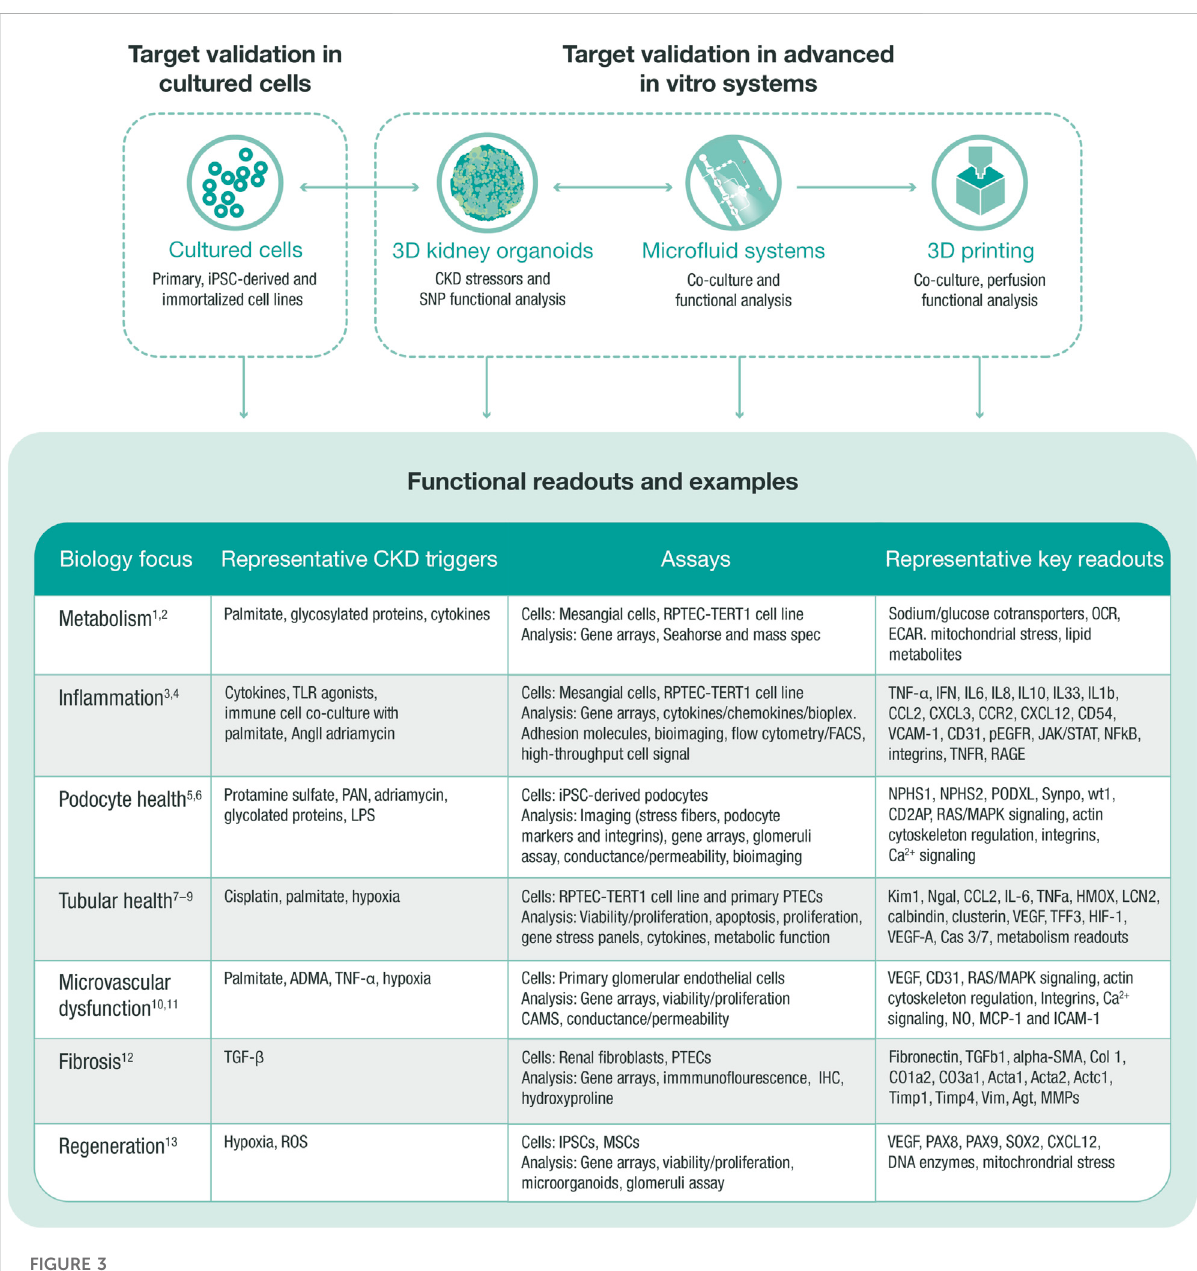
FIGURE 3 Invitro targetvalidationprocess. Invitro targetvalidationinculturedcellsisusedasa fi rstapproachtovalidateandscreenseveraltargets,aiming totriagetargetswith strongsupport forfurthertarget validationinadvanced invitro systems.Datafromall systemsfeedinto eachothertoselectthe mosttranslatablemodelandde fi nethecorrectstressorthatregulatestarget andpathway. An invitro target validation toolboxmay comprisevarious assays, stressors, and readouts, which are chosen based on the disease biology of the target. ADMA, asymmetric dimethylarginine (arginine metabolite); CKD, chronic kidney disease; ECAR, extracellular acidi fi cation rate; HGEC, human glomerular endothelial cell; HMOX, hem oxygenase; IHC, immunohistochemistry; iPSC, induced pluripotent stem cell; MMPs, matrix metalloproteinases; MSC, mesenchymal stem cell; OCR, oxygen consumptionrate;PAN,pyromycinaminonucleoside;PTEC,proximaltubularepithelialcell;RPTEC,renalproximaltubularepithelialcell;SNP,single nucleotide polymorphism; TGF, transforming growth factor; TLR, toll-like receptor; ROS, reactive oxygen species. 1. Faivre A et al. Front Med (Lausanne) 2021; 8:742072; 2. Imasawa T et al. The International Journal of Biochemistry and Cell Biology 2013; 45:2109 – 2118.3. Oates JC et